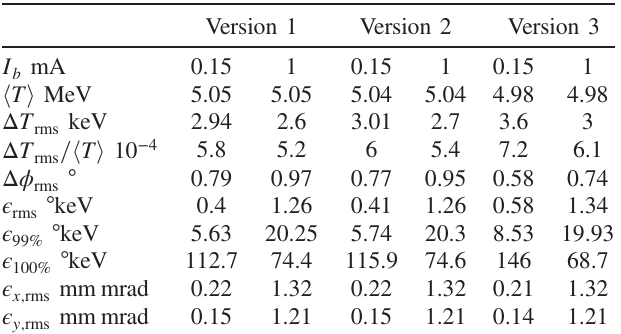
TABLE IV. Comparison of longitudinal bunch data of the researched normal conducting MAMBO versions as found 0.1 m behind the end of the last rf section. For a complete picture the transverse rms emittances are also